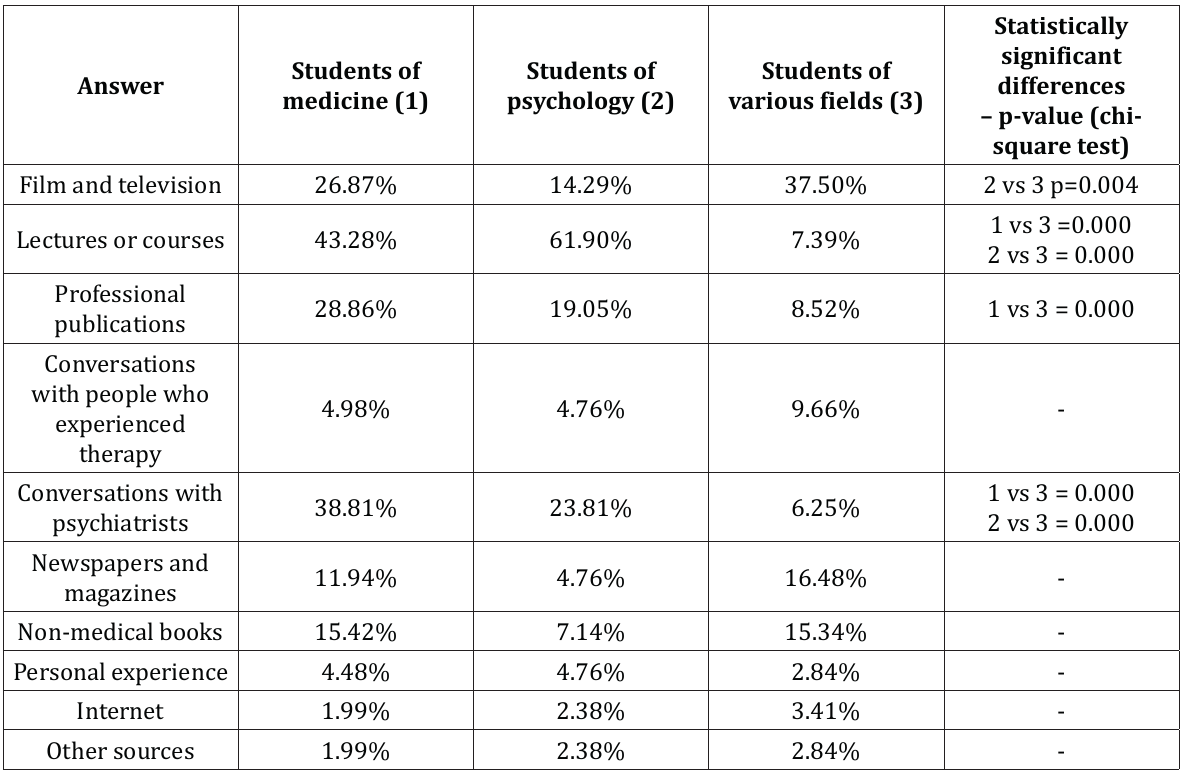
Table 2. Sources of knowledge among students